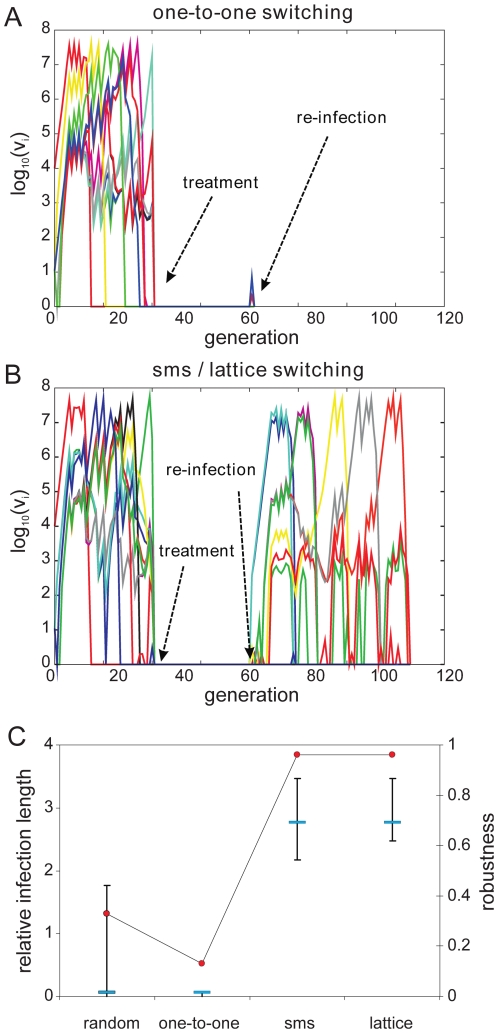
Effects of switching pattern on malaria infection dynamics during
re-infection.Simulating infection, clearance and re-infection by the same pathogen
reveals the vulnerability of the highly ordered one-to-one switching
pathway (A). The expansion-contraction process within the
sms pathway allows for greater flexibility to
overcome the inhibitory responses to find an alternative route of
expression (B). This is clearly demonstrated by both robustness,
measured as the proportion of runs where secondary infections were
successfully established, and the length of secondary infection (C).
Shown are the median (blue bars) and lower and upper quartiles of
500 model realisations.